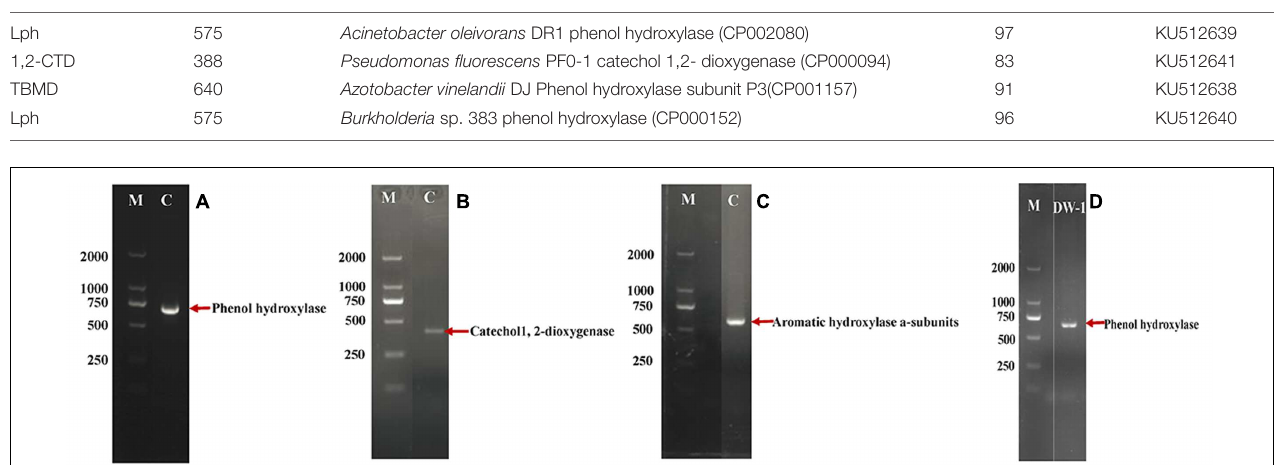
FIGURE 6 | PCR product analogs of the indicated catabolic genotypes obtained from DNA extracts of enrichment culture C on the 50th day during phenol acclimation and strain DW-1 using primers for Lph (A,D), 1,2-CTD (B) and TBMD (C). The arrows denote amplicon fragment sizes.